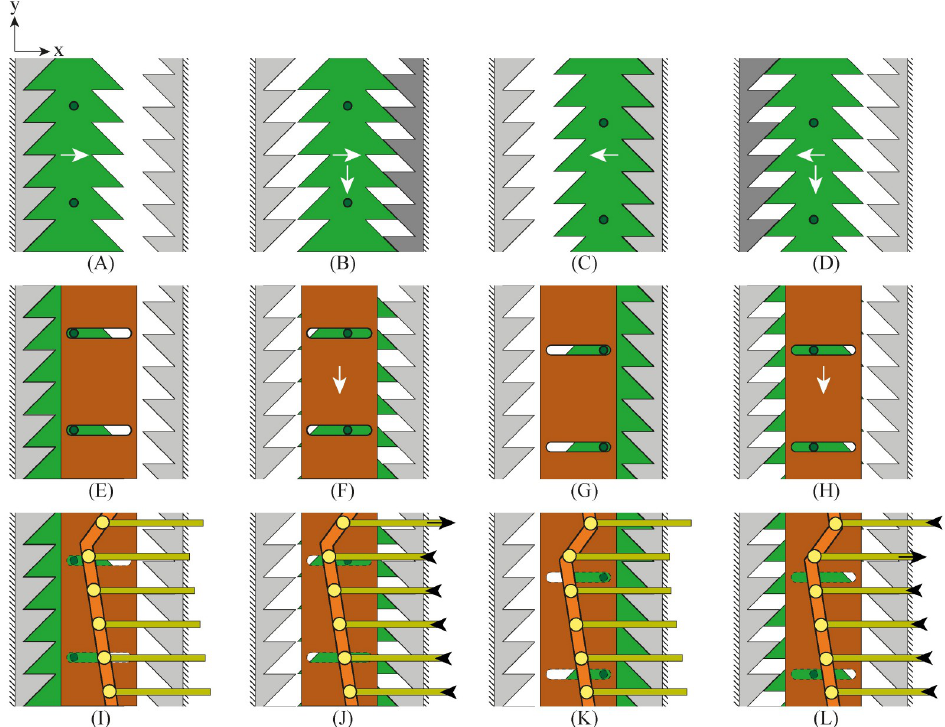
Fig 4. Schematic representation of the selector motion mechanism in 2D, including the selector (green), housing (grey), cam (orange), and needle segment holders (yellow). The columns show the subsequent steps in the motion cycle. The rows show the different layers of the